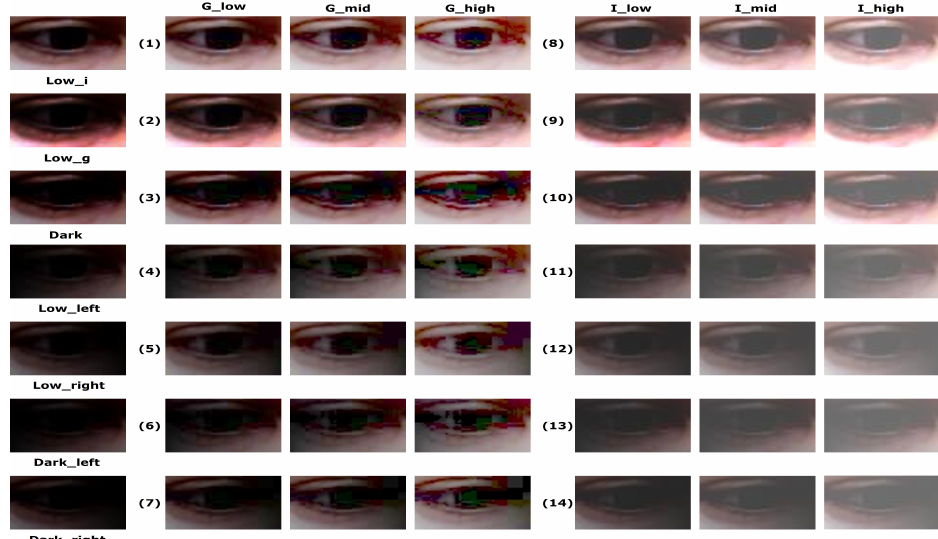
Figure 12. Examples of images modified by the baseline